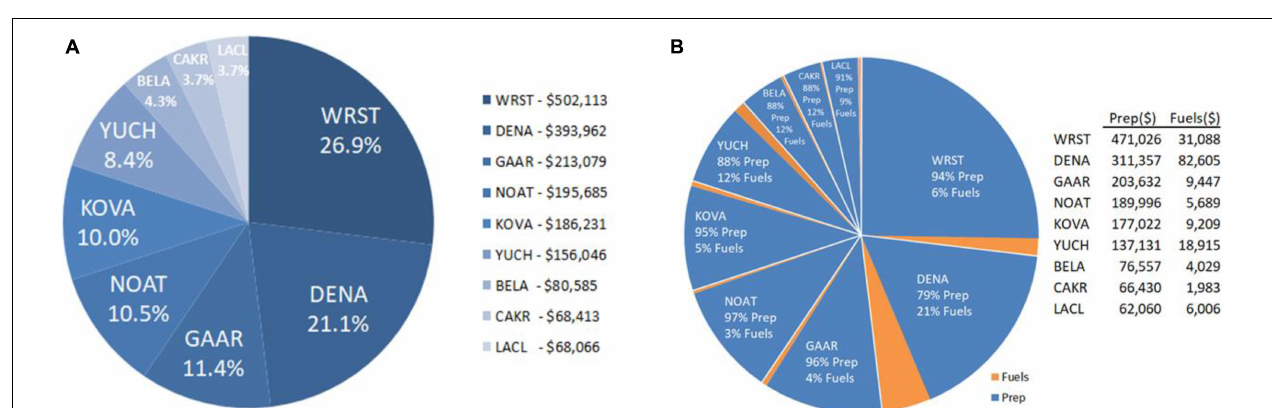
FIGURE 8 | (A) Allocation of a zone budget of $1,864,181 to each of the nine parks based on proportionate performance; (B) individual park total budgets allocated between fuels and preparedness programs.